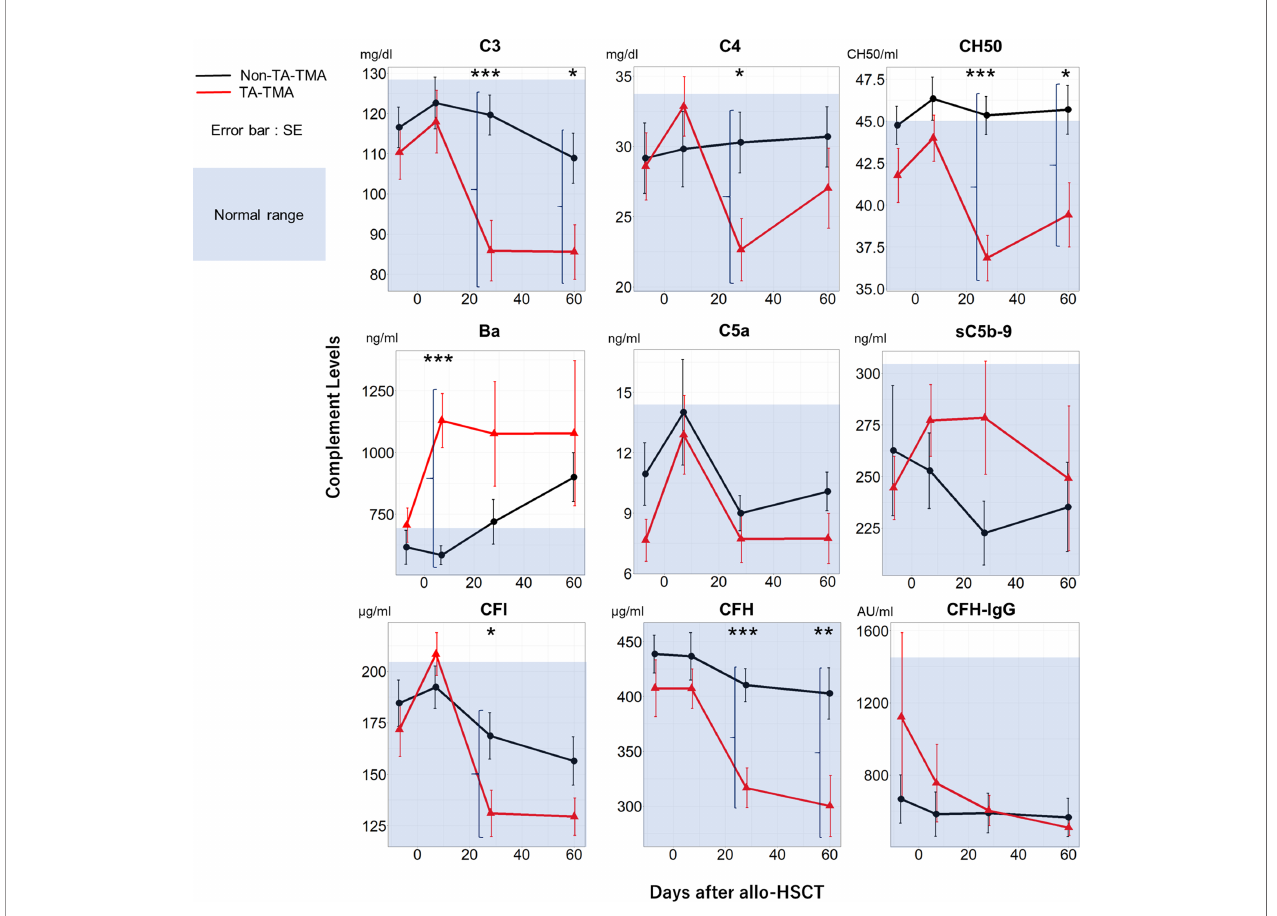
FIGURE 2 | Temporal changes in complement protein levels in the TA-TMA and non-TA-TMA groups. Plasma levels of C3, C4, CH50, Ba, C5a, sC5b-9, CFI, CFH, and CFH-IgG at four time points (pre-conditioning, Day 7, Day 28, and Day 60) are shown for TA-TMA (red line) and non-TA-TMA (black line) patients. The blue shadow indicates the normal range in Japanese adults. * P < 0.05; ** P < 0.01; *** P < 0.001. SE, standard error; TA-TMA, transplant-associated thrombotic microangiopathy.